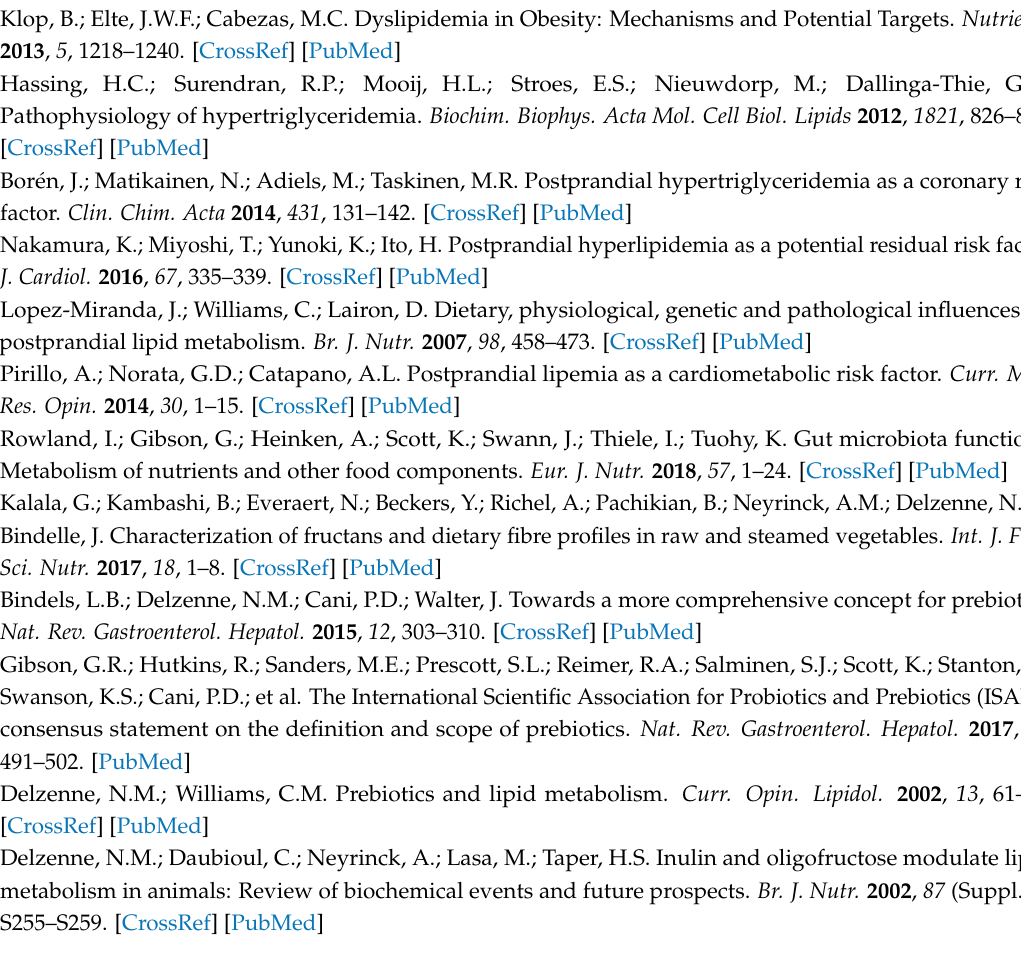
Table S2: Sequences of primers used for real-time quantitative